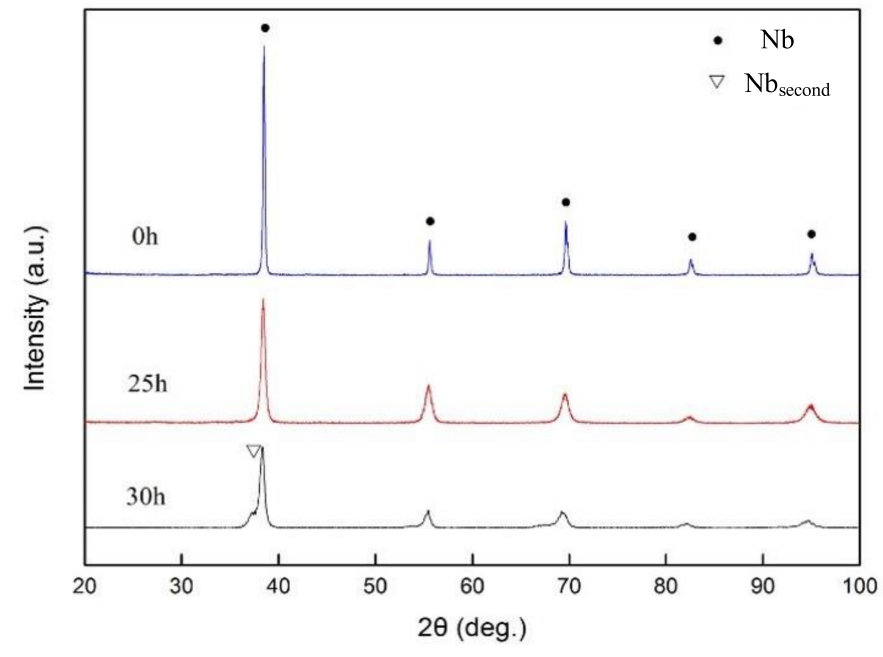
Figure 3. X-ray diffraction (XRD) patterns of composite powders after different milling